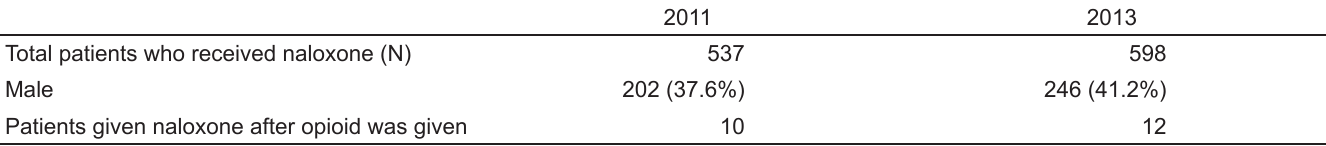
Table 2a. Summary of naloxone use in the emergency